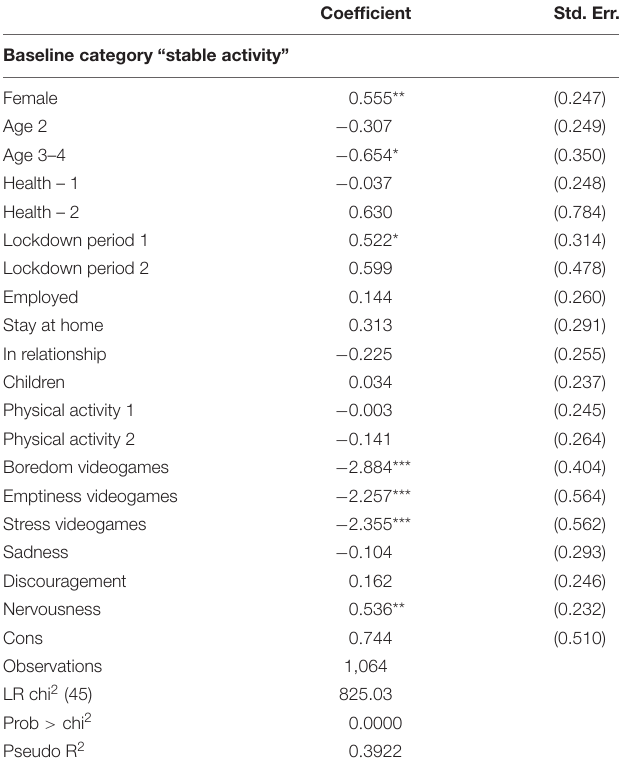
TABLE 6A | Multinomial logistic regression on videogame play increase: category “no